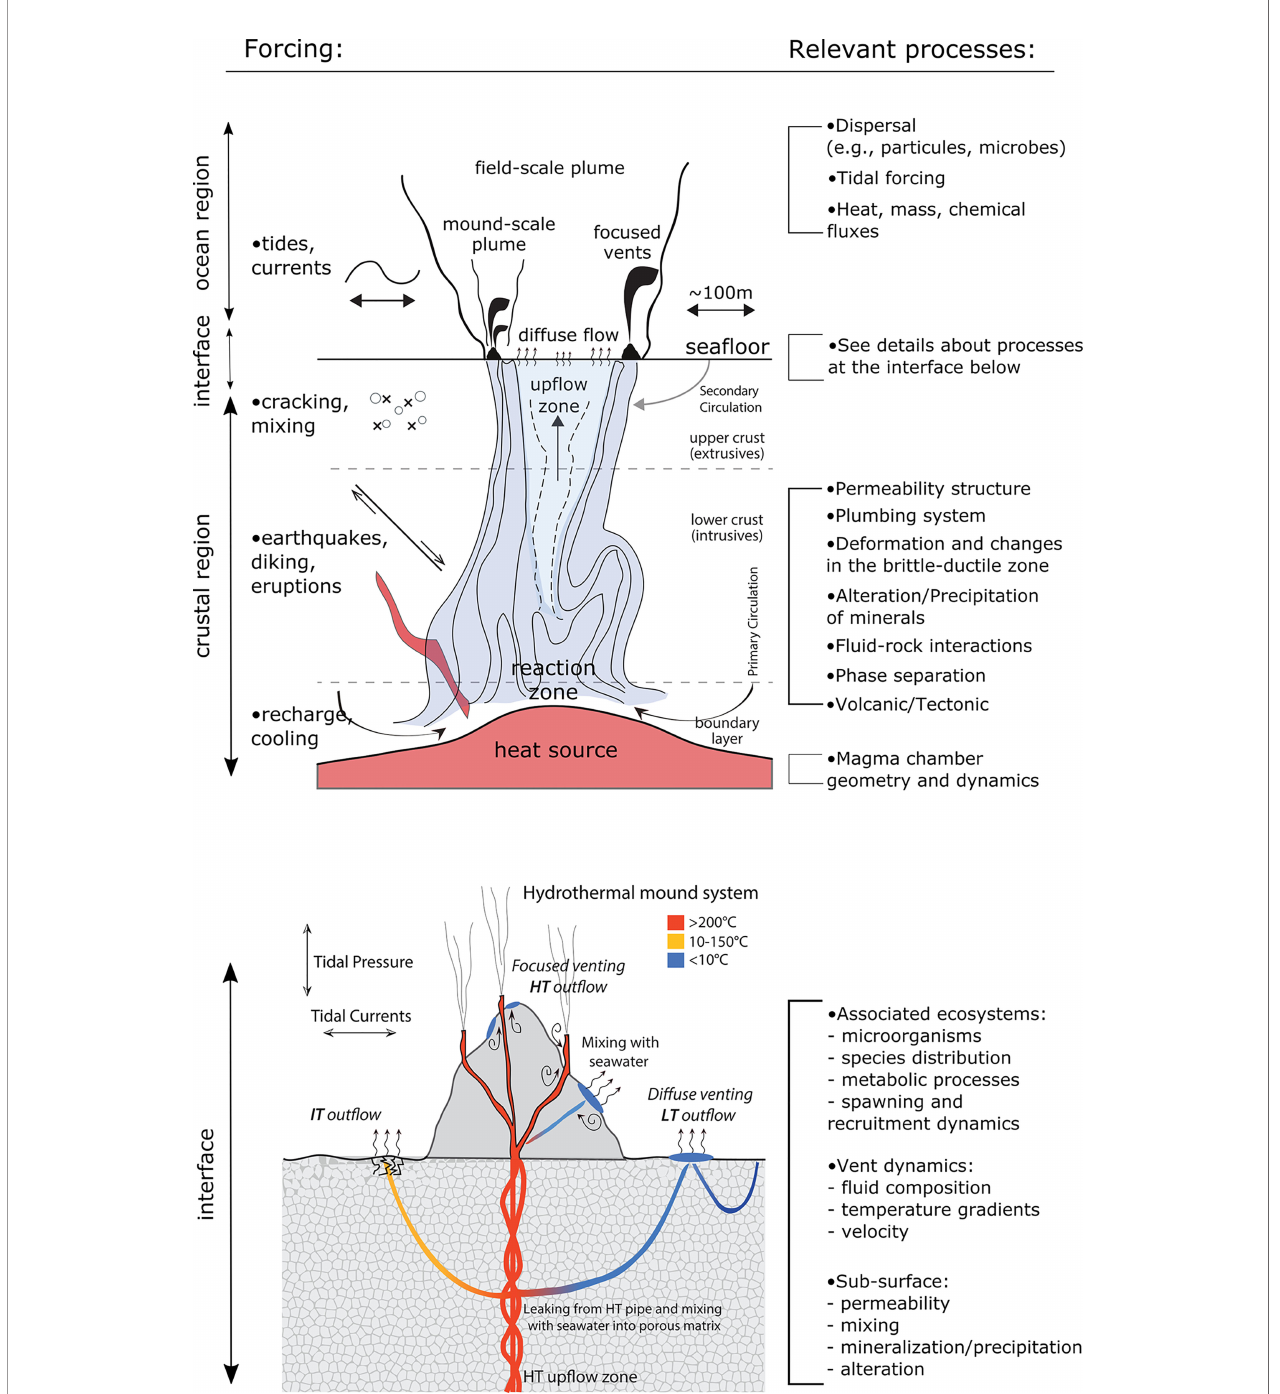
FIGURE 5 | Top Conceptual model of a hydrothermal plumbing system at depth, with the upwelling of a single plume above the magmatic heat source that is focused along high-permeability zones associated with main faults and fractures networks. Bottom Close-up of a hydrothermal mound edi fi ce. High-temperature (HT) out fl ow is directly fed by the high-temperature up- fl ow zone (here represented as an anastomosing, interconnected series of conduits), intermediate-temperature (IT) out fl ow is fed from leakage from the HT pipe and mixed with cold water into the porous matrix [i.e., hypothesis (1)] and low-temperature (LT) out fl ow is fed from either hypothesis (1) or conductively heated bottom water drawn into the sea fl oor as part of a secondary circulation system [i.e., hypothesis (2)]. Modi fi ed from Barreyre et al.